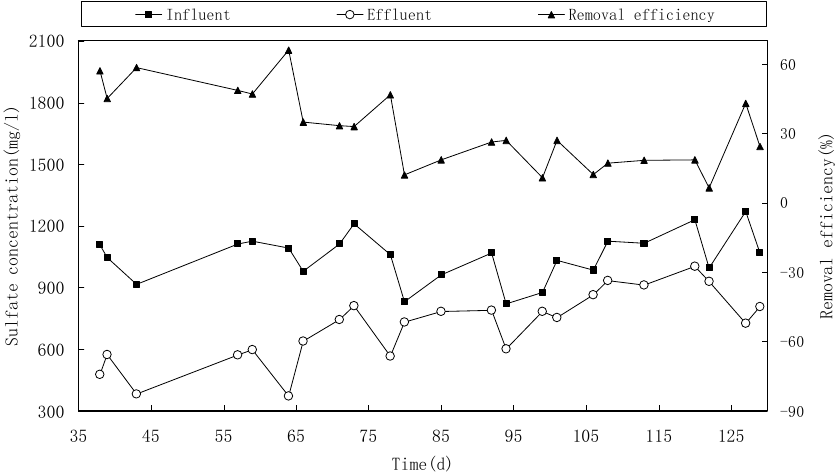
Figure 3. Sulfates removal of the hybrid anaerobic baffled reactor (HABR) during operational period of 37–131 days.